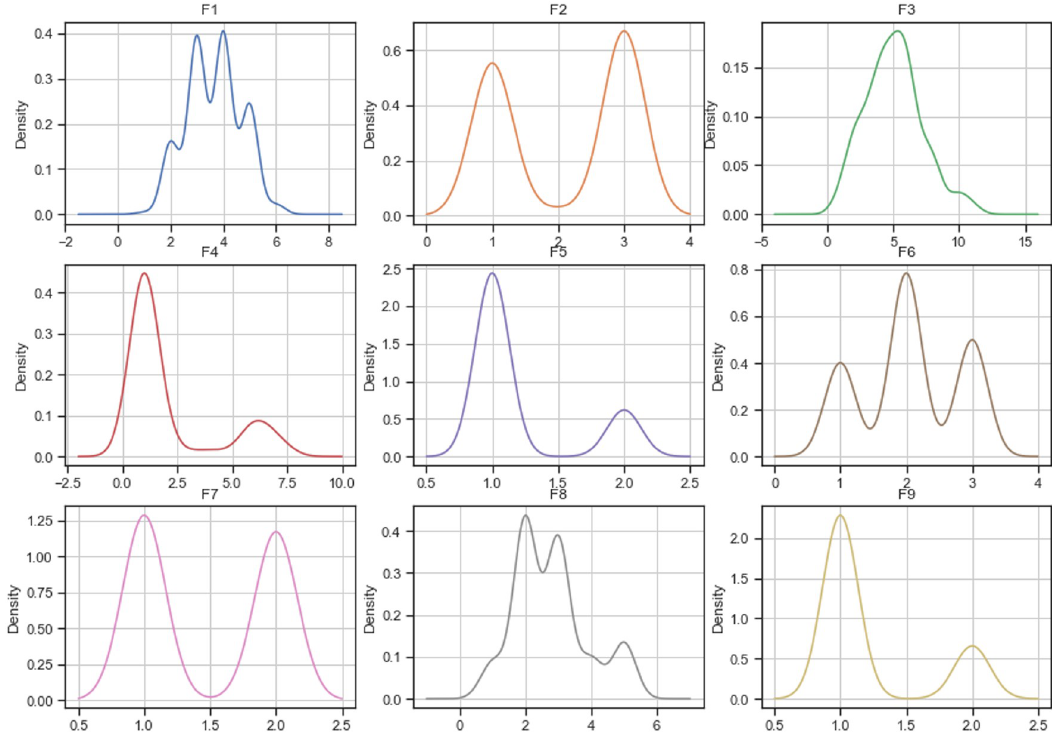
Fig 5. Distribution of complete breast-cancer